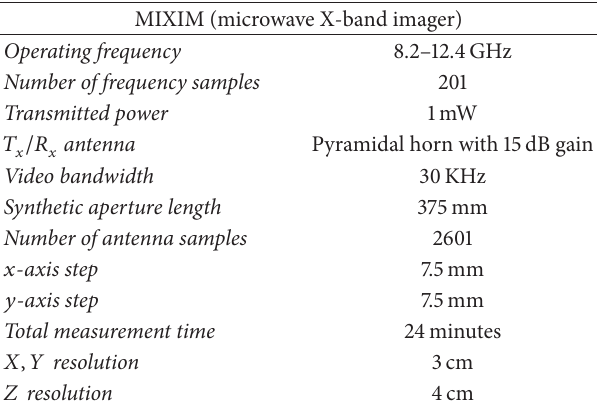
Table 2: Specifications of the microwave